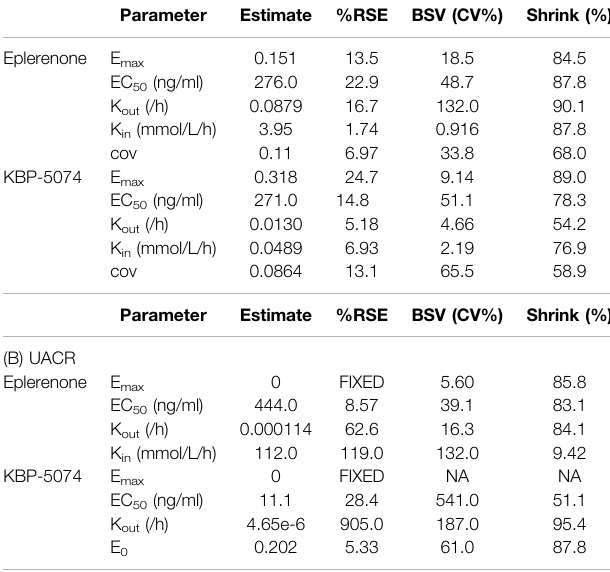
TABLE 2 | PK/PD modeling analysis: PK parameters for eplerenone and KBP- 5074. Parameter